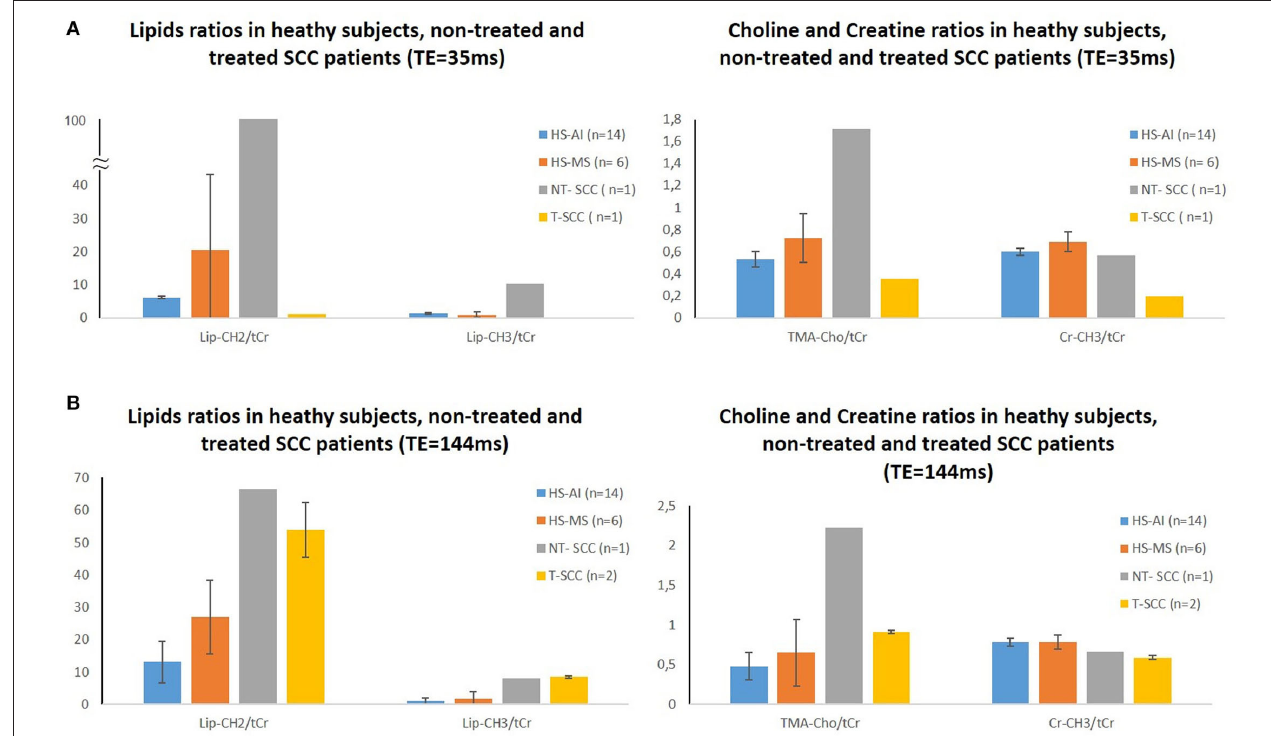
FIGURE 3 | Lipids, choline, and creatine metabolites ratios differences between healthy subjects and patients with nontreated and treated SCC measured at TE = 35ms (A) and TE = 144ms (B) . Note that Lip-CH 2 represents IMCL-CH 2 and IMCL-CH 2 and Lip-CH 3 represents IMCL-CH 3 and IMCL-CH 3 . HS-AI, healthy subjects-anterior inferior part of the tongue; HS-MS, healthy subjects-medial superior part of the tongue; NT-SCC, patient with nontreated SCC; T-SCC, patient with treated SCC.